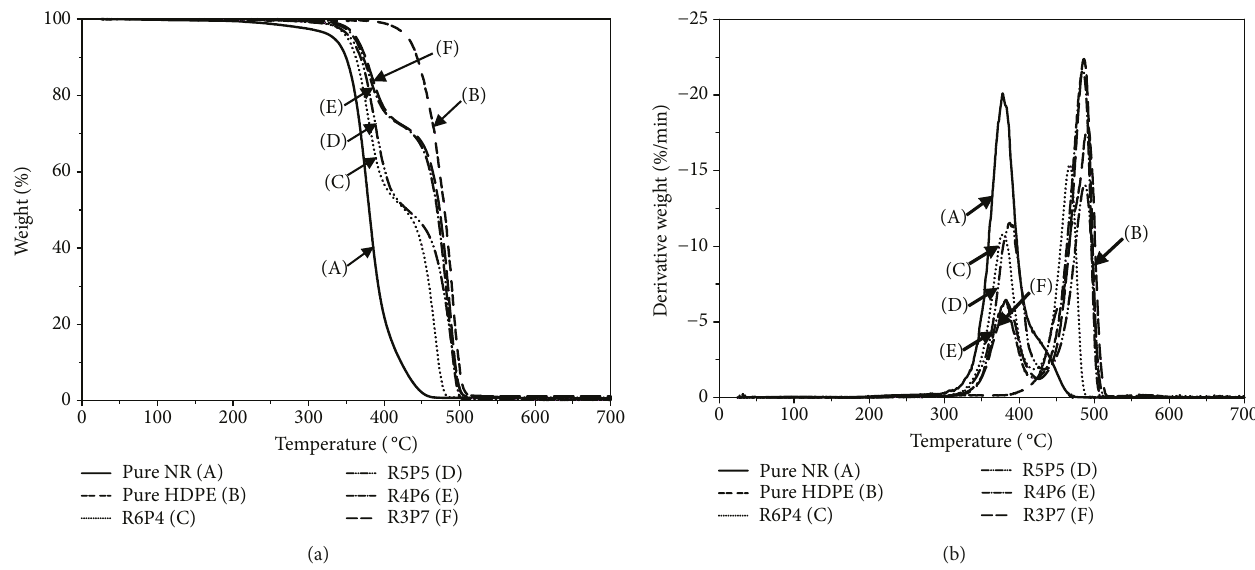
Figure 1: Curves of (a) TGA and (b) DTG for pure NR, pure HDPE, and NR/HDPE blends at various blend ratios. Table 2: Thermal data obtained from TGA thermograms of TPNR and TPNR/RWS composites. Temperature at di ff erent weight loss ( ° Formulation